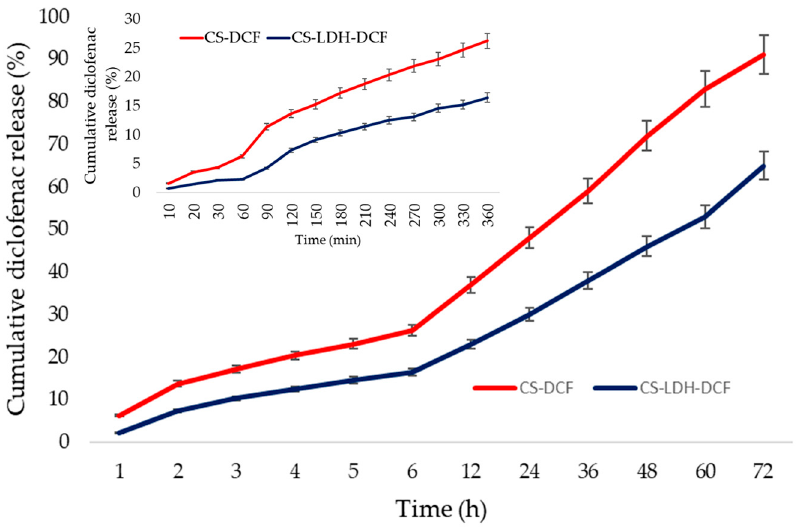
Figure 8. Cumulative diclofenac (%) release in time (h) for first 72h and inset (min) for first 6 h.